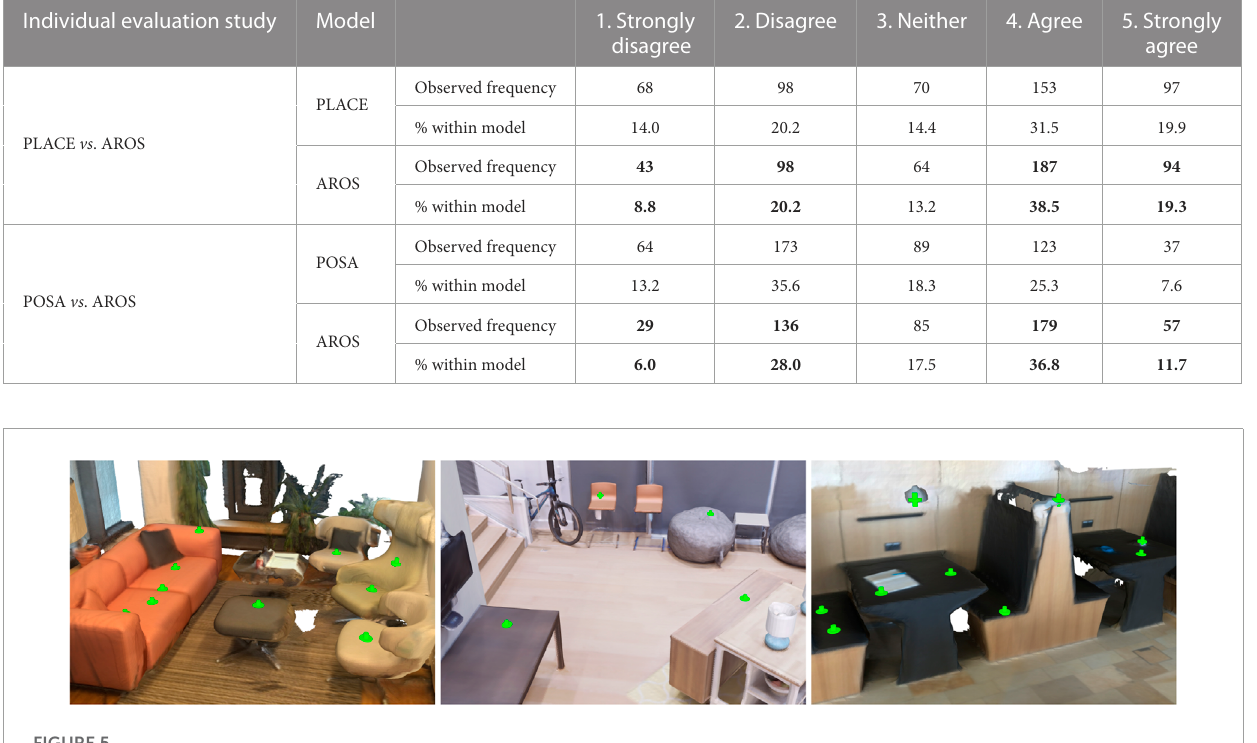
TABLE3 Cross-tabulationdataofindividualevaluationstudiesonrandomlyselectedlocations.Thebestareinboldface. Individual evaluation study